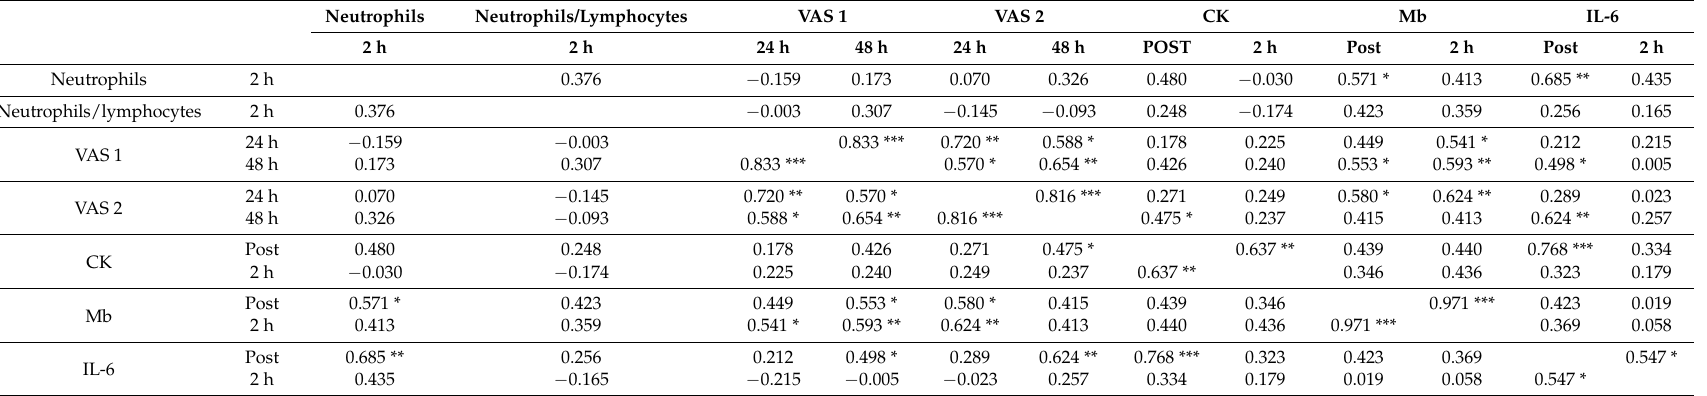
Table 1. Relationships among muscle soreness, muscle damage and inflammatory markers after downhill running in placebo and H 2